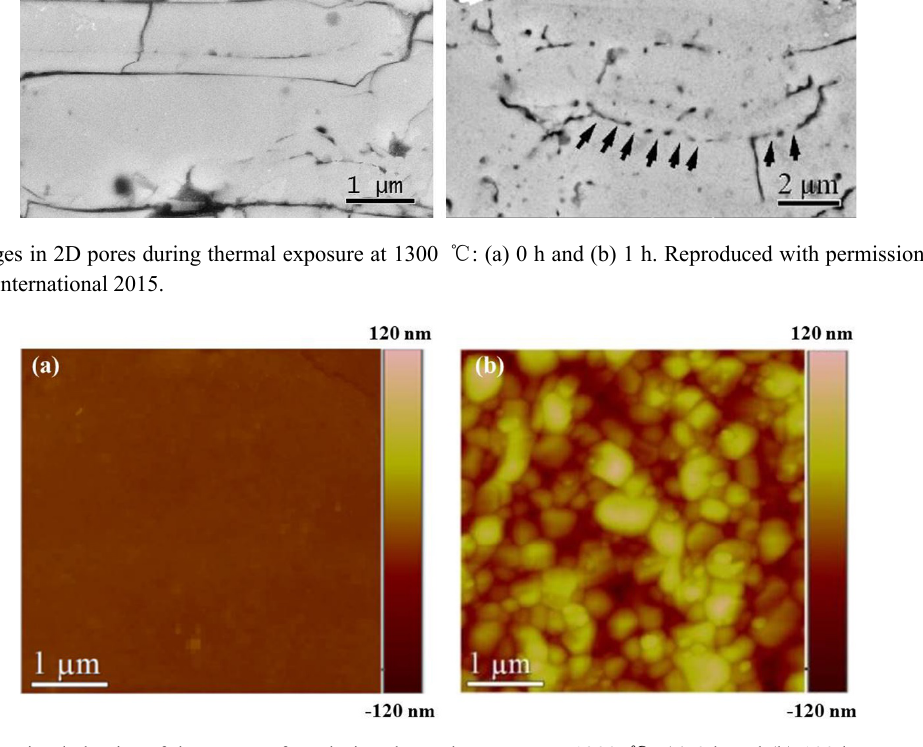
Fig. 32 Roughening behavior of the pore surface during thermal exposure at 1300 ℃ : (a) 0 h and (b) 100 h. Reproduced with permission from Ref. [164], © ASM International